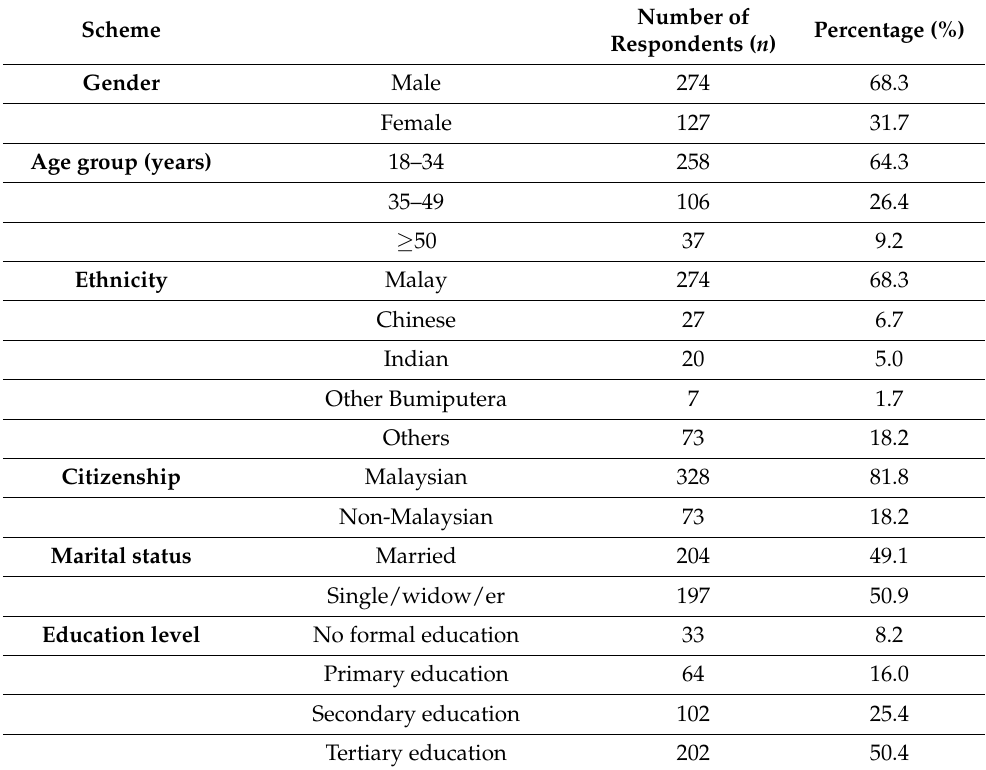
Table 1. Socio-demographic characteristics of respondents ( n =